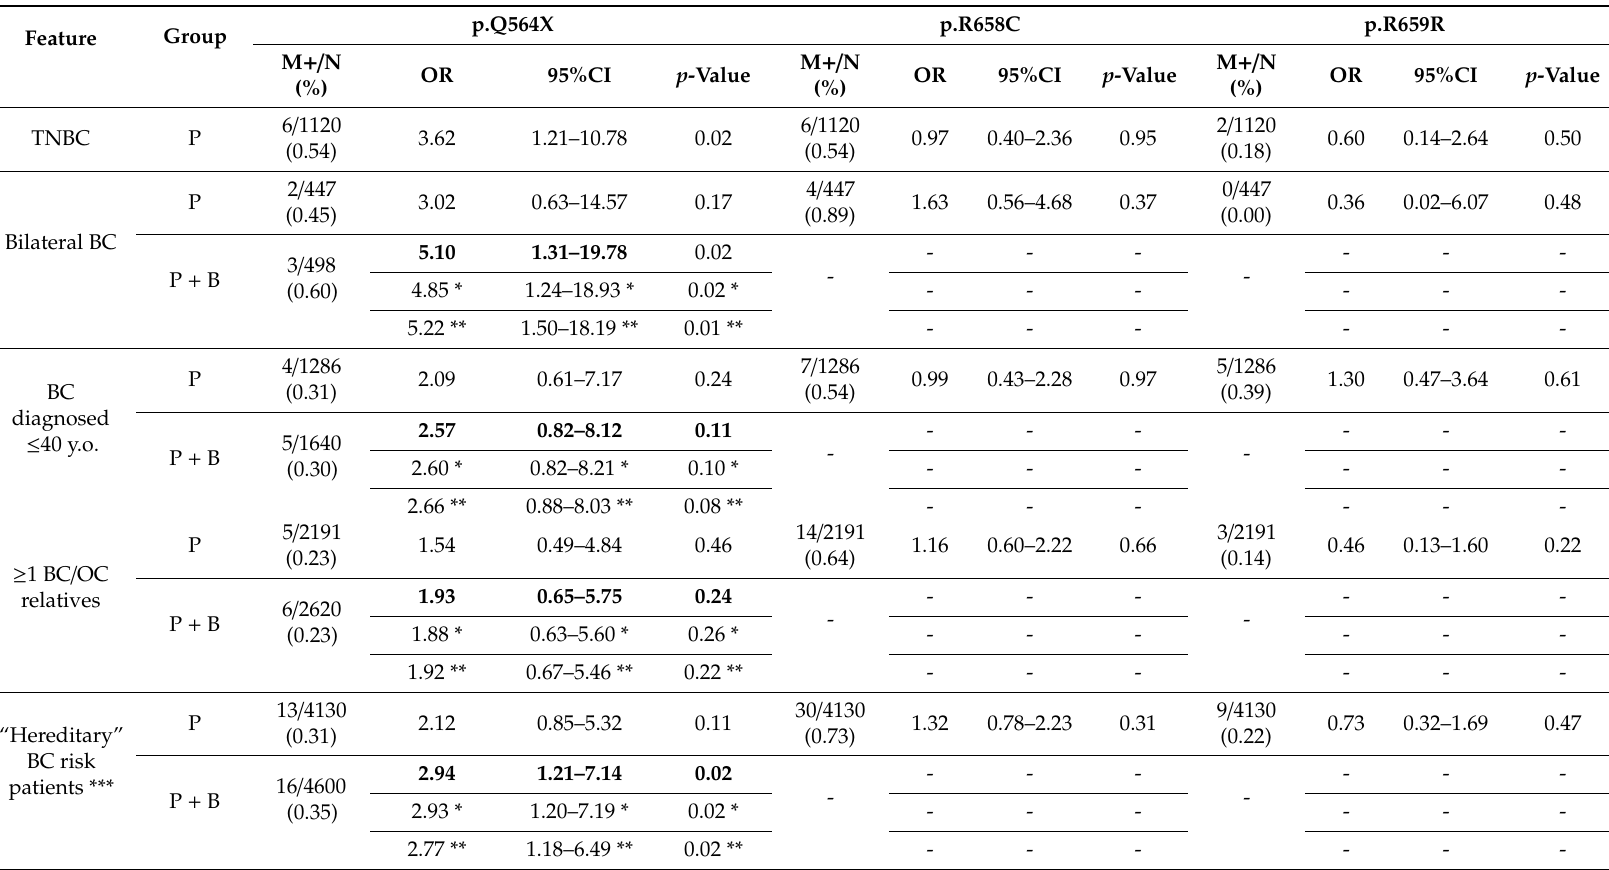
Table 2 & Table 3: P: POLISH group; B: BELARUSIAN group; P + B: POLISH and BELARUSIAN GROUP; M + : number of patients with a particular variants; N: number of all genotyped patients; y.o.: years old; *: adjusted for the origin of the study; **: a Mantel-Haenszel method under the fixed e ff ects model (please note that this analysis may be biased due to no mutations in the BELARUSIAN control group); ***: TNBC # and / or bilateral BC and / or BC diagnosed ≤ 40 y.o. and / or ≥ 1 BC / OC relative; #: TNBC status was not determined in the BELARUSIAN